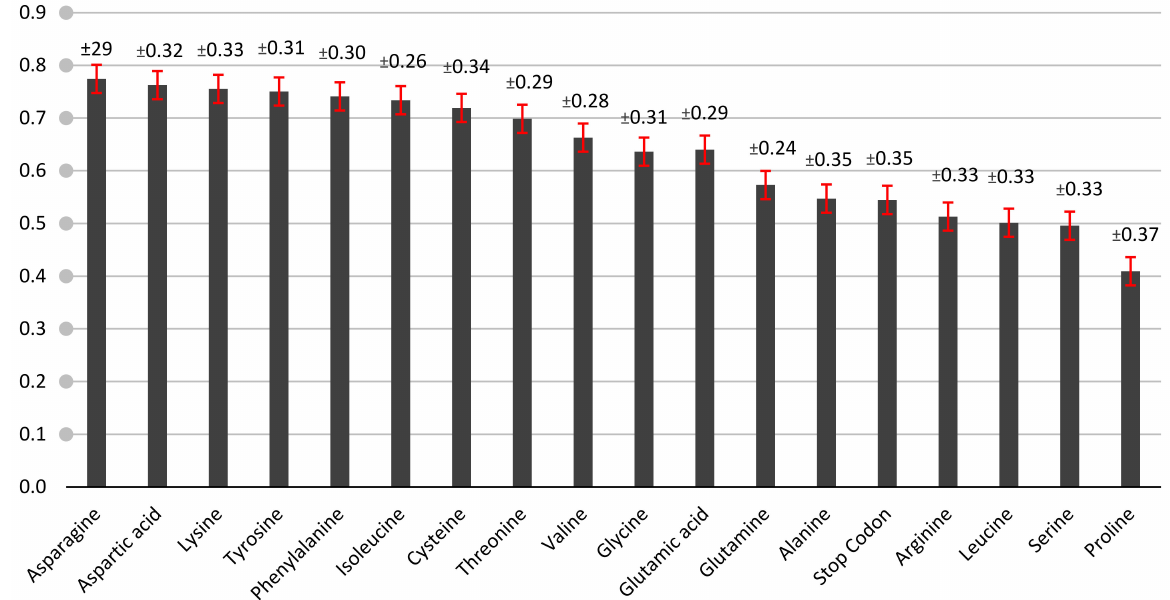
Figure 3. The MRCBS mean in heat shock protein sequences for the Solanum lycopersicum cultivar Heinz 1706, excluding Methionine and Tryptophan, with standard error shown by the red line and label with standard deviation ( ±